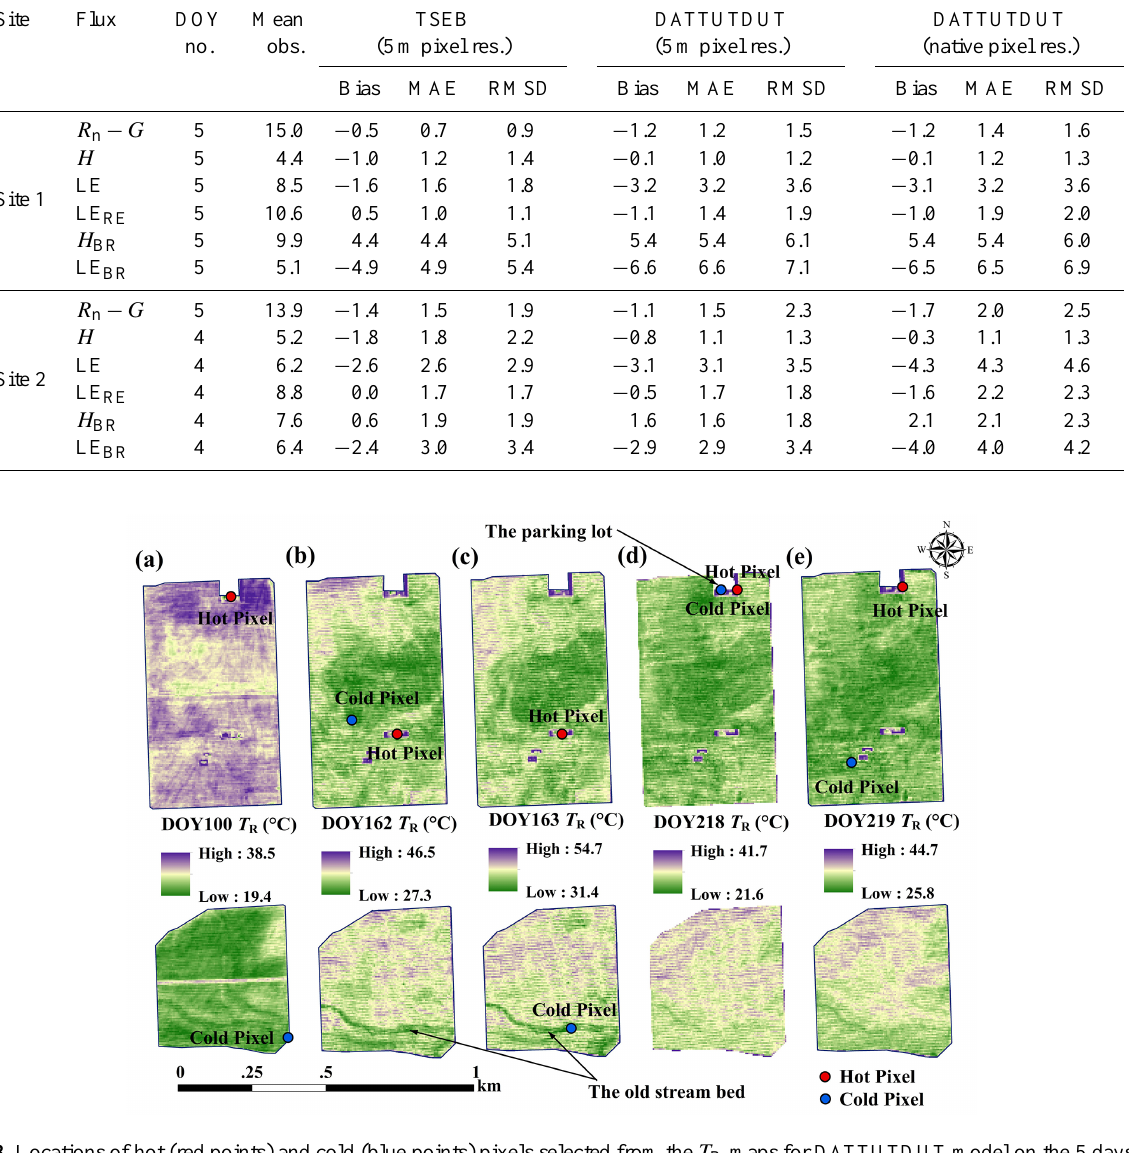
163, and 218, but not on DOY 162 and DOY 219 when